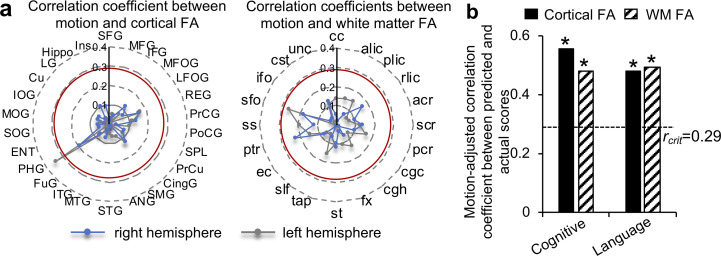
Comprehensive motion-related analyses collectively demonstrate that motion did not confound the significant prediction found in this study.(a) No significant correlation between head motion estimates (quantified by mean framewise displacement) and fractional anisotropy (FA) values of any of 92 parcellated brain regions was found after false discovery rate (FDR) correction. 92 brain regions included 52 cortical and 40 white matter (WM) regions used in present study and were parcellated based on a neonate atlas (Feng et al., 2019). Radar charts show the correlation coefficients between motion estimates and regional FA values from cortical (left panel) and WM (right panel) regions from both hemispheres. Red circles in radar charts indicate critical r value corresponding to p=0.05 before FDR correction. Before FDR correction, significant correlation was only found for the left PHG (parahippocampal gyrus) (p=0.02, before correction). After correction of multiple tests, significant correlation for the left PHG no longer existed. Abbreviations of parcellated cerebral cortical regions (Feng et al., 2019) can be found in Supplementary file 3. Abbreviations of parcellated WM regions are as follows: cc: corpus callosum; alic: anterior limb of internal capsule; plic: posterior limb of internal capsule; rlic: retrolenticular part of internal capsule; acr: anterior corona radiata; scr: superior corona radiata; pcr: posterior corona radiata; cgc. cingulum cingulate gyrus part; cgh: cingulum hippocampal part; fx: fornix; st: stria terminalis; tap: tapetum; slf: superior longitudinal fasciculus; ec: external capsule; ptr: posterior thalamic radiata; ss: sagittal stratum; sfo: superior fronto-occipital fasciculus; ifo: inferior fronto-occipital fasciculus; cst: corticospinal tract; unc: uncinate fasciculus. (b) Correlations between the predicted and actual cognitive or language outcomes remained significant after adjustments of motion estimates in regional cortical and WM FA feature vectors used for prediction model. Dashed line indicates critical r value corresponding to p=0.05. * indicates significant (p<0.05) correlation.